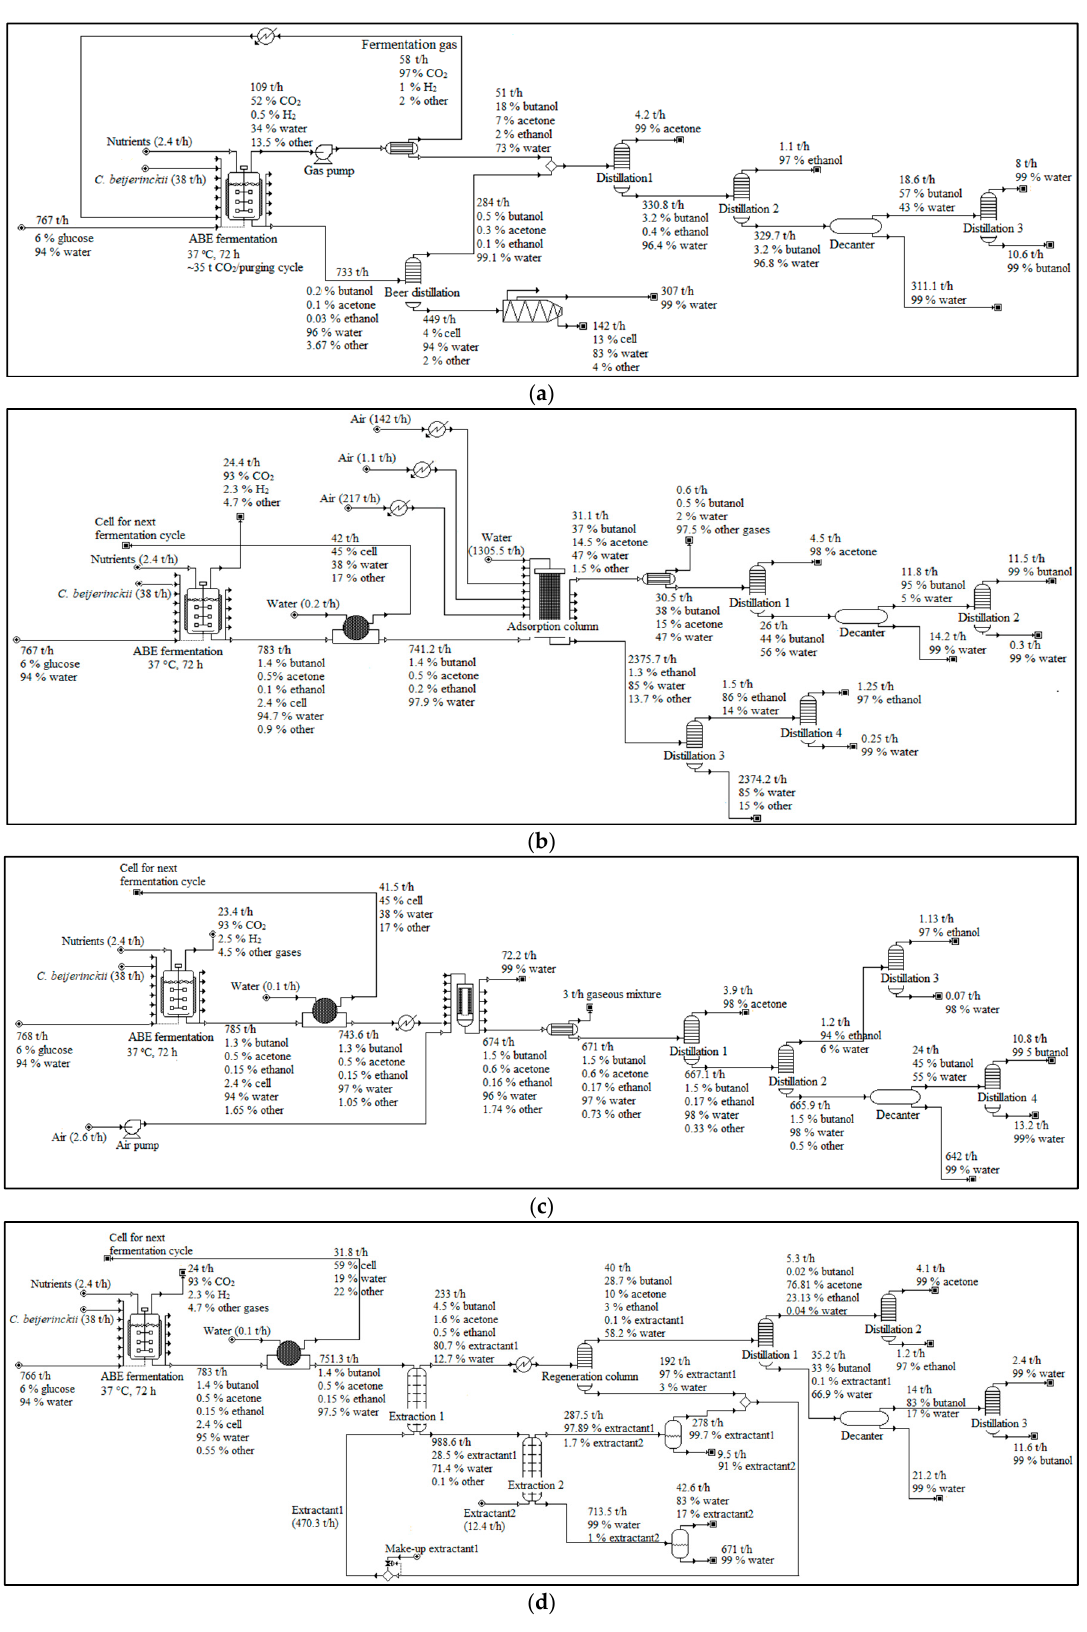
Figure 5. Product separation and purification set-up used in the simulation models. ( a ) in-situ stripping; ( b ) adsorption-distillation; ( c ) pervaporation-distillation; ( d ) dual extraction-distillation. Note that this figure only includes major unit operations. More detailed plant set-ups were actually used in the simulations.